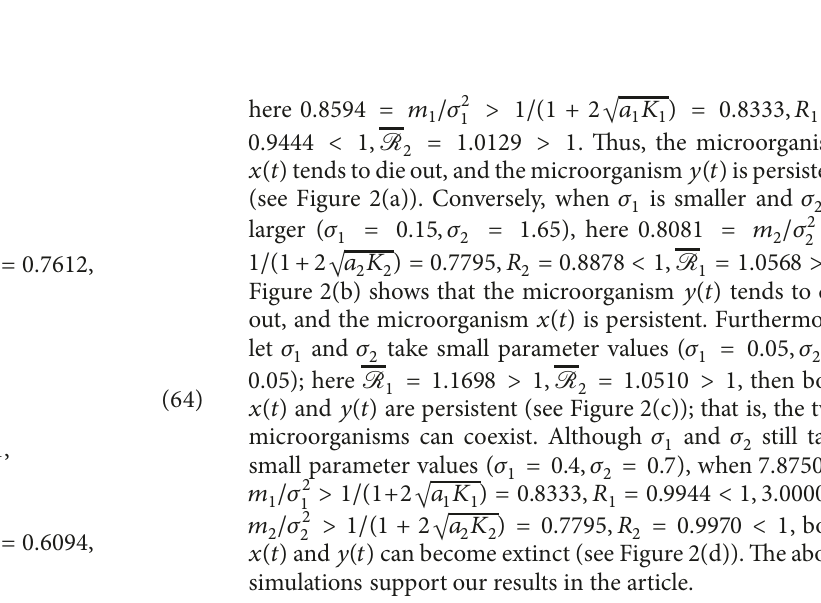
Figure 1: Computer simulation of the paths 𝑆(𝑡), 𝑥(𝑡),𝑦(𝑡) for the chemostat model, where (a) is the stochastic system for 𝜎 1 = 1.7,𝜎 2 = 1.9. (b) is the corresponding deterministic system of (a) for 𝜎 1 = 0,𝜎 2 = 0.